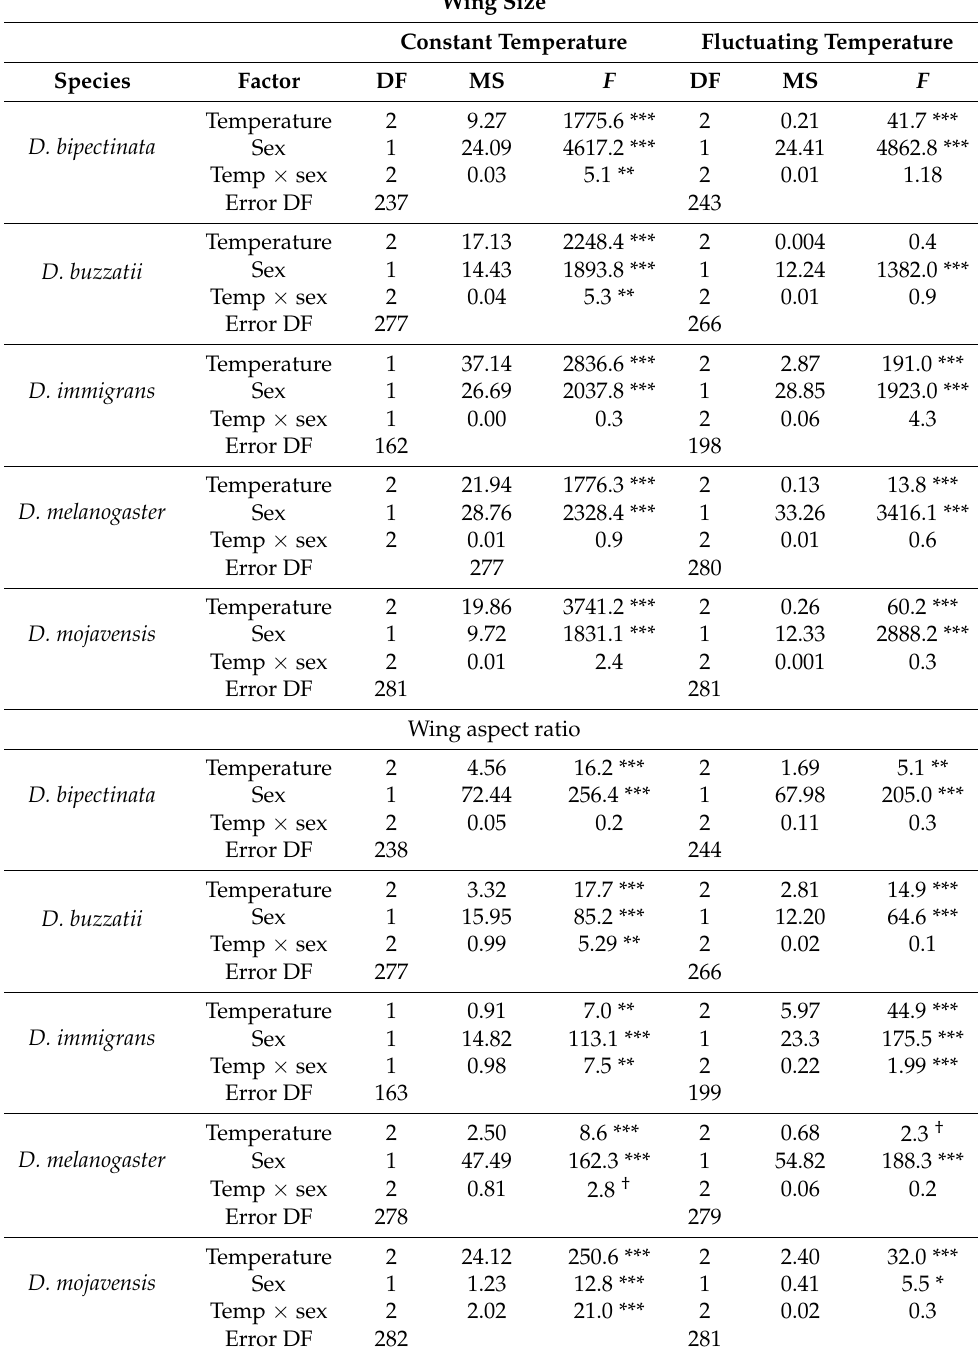
Table 2. Effects of temperature and sex on wing size and wing aspect ratio within species. Separate tests were conducted for the constant (20, 25, and 30 ◦ C) and fluctuating temperature (25 ◦ C CT, small and large amplitude FT)